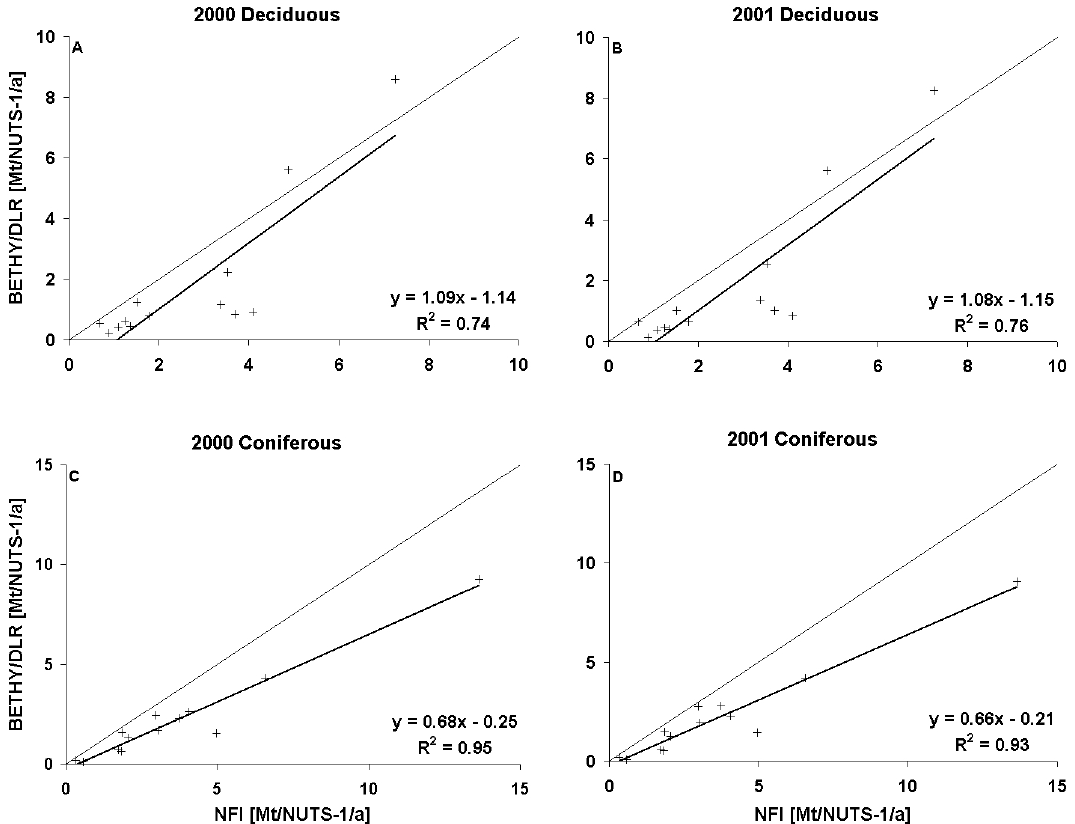
Fig. 4. Estimated above-ground biomass increment from modelled NPP (CAI) versus empirical data from the NFI (MAI) for Germany’s deciduous and coniferous trees for 2000 and 2001. Each cross represents one NUTS-1 region. Thick lines show linear regressions. Values are given in megatons per NUTS-1 unit per year.